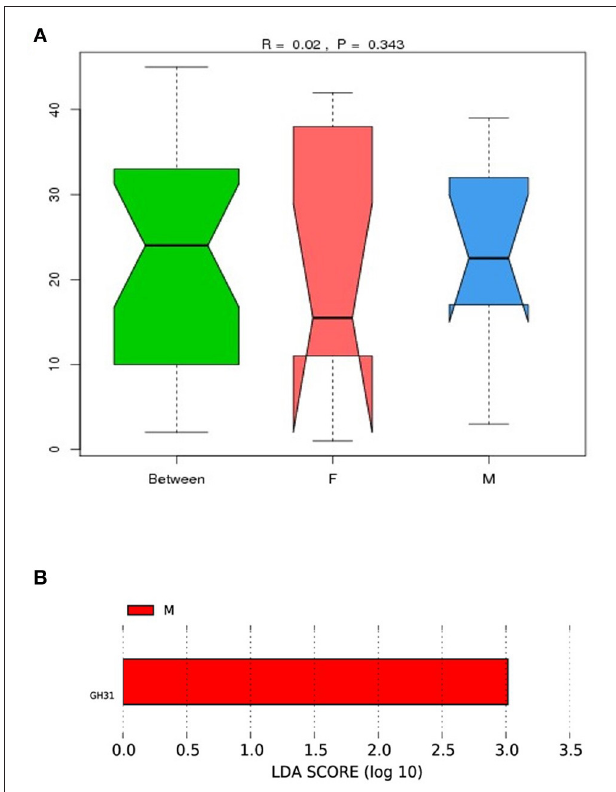
FIGURE 4 | (A) Analysis of similarity (ANOSIM) between female (F) and male (M) Japanese quail ( Coturnix japonica ) based on the CAZy database. The horizontal axis represents the grouping information; the vertical axis indicates the distance data, and “Between” is the combined information for both groups. The median line for “Between” being higher than those of the other two groups suggests that the groupings were appropriate. The R -value was between − 1 and 1 and > 0, indicating a significant difference between the groups. The P -value represents the reliability of the statistical analysis, and P < 0.05 indicates statistical significance; (B) Different functional capacities of gut microbiome based on Carbohydrate-Active Enzymes (Cazy) analysis between female (F) and male (M) Japanese quail (Coturnix japonica).